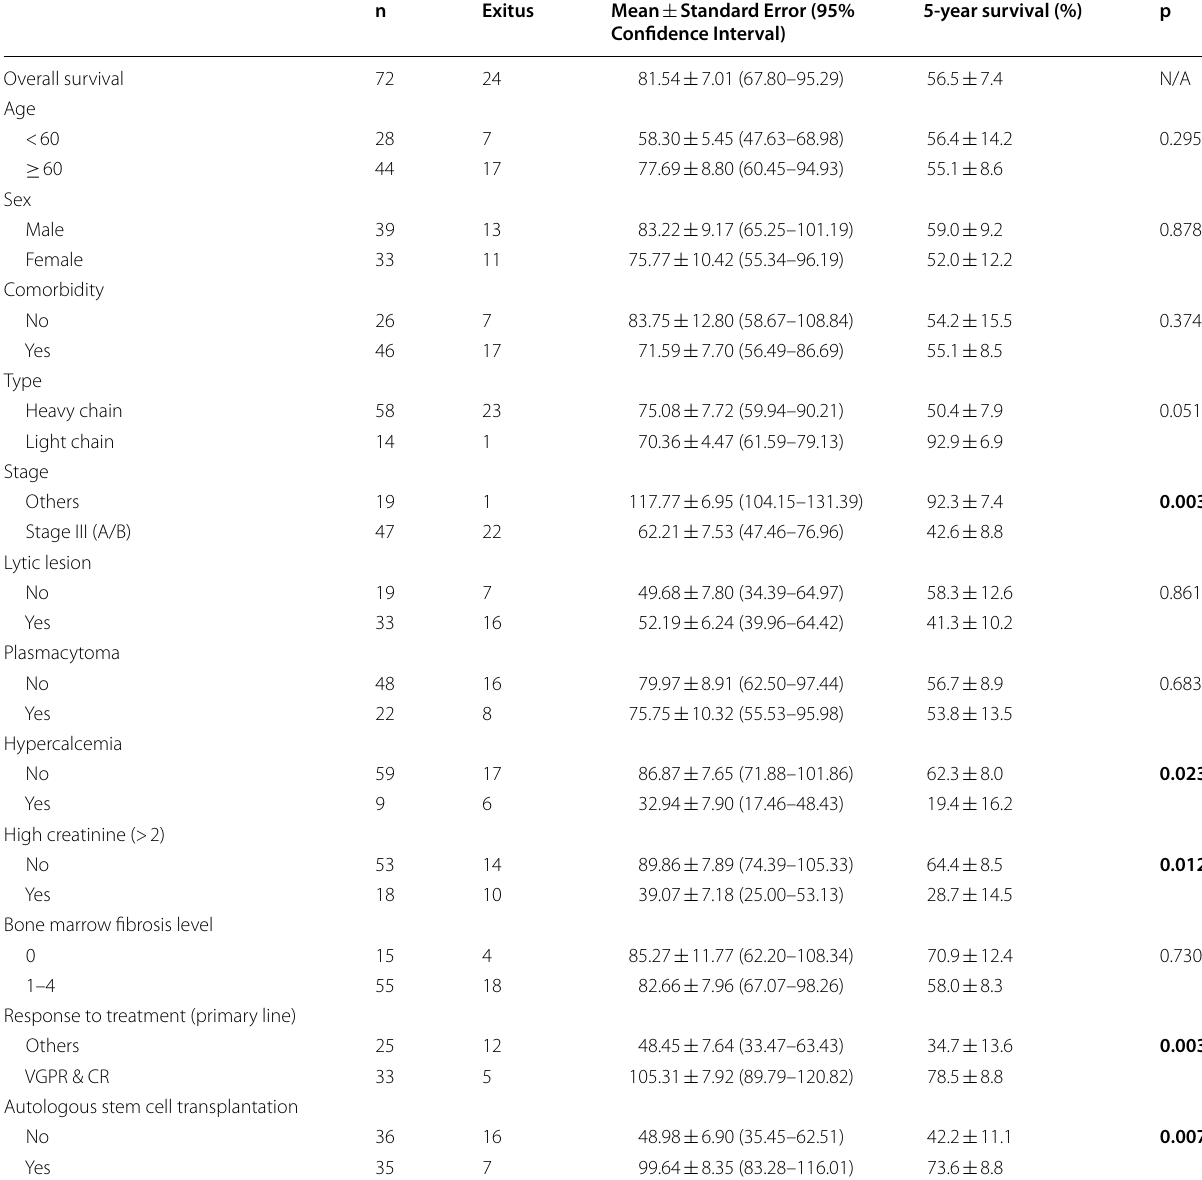
Table 2 Comparison of Survival times (months) calculated using Kaplan–Meier analysis and the groups with the Log-rank test